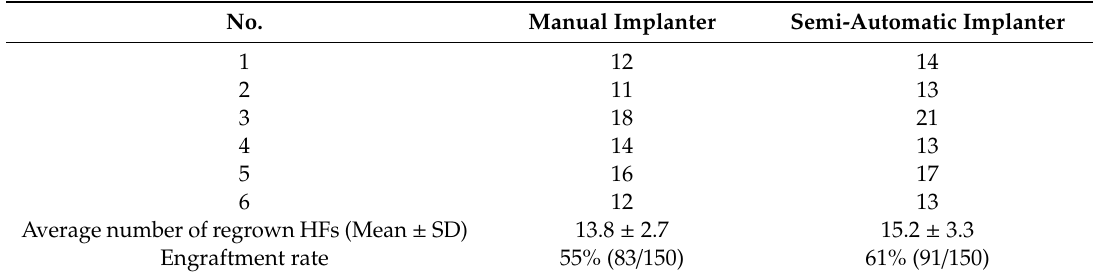
Table 3. Comparison of HF engraftment rate by the two devices.